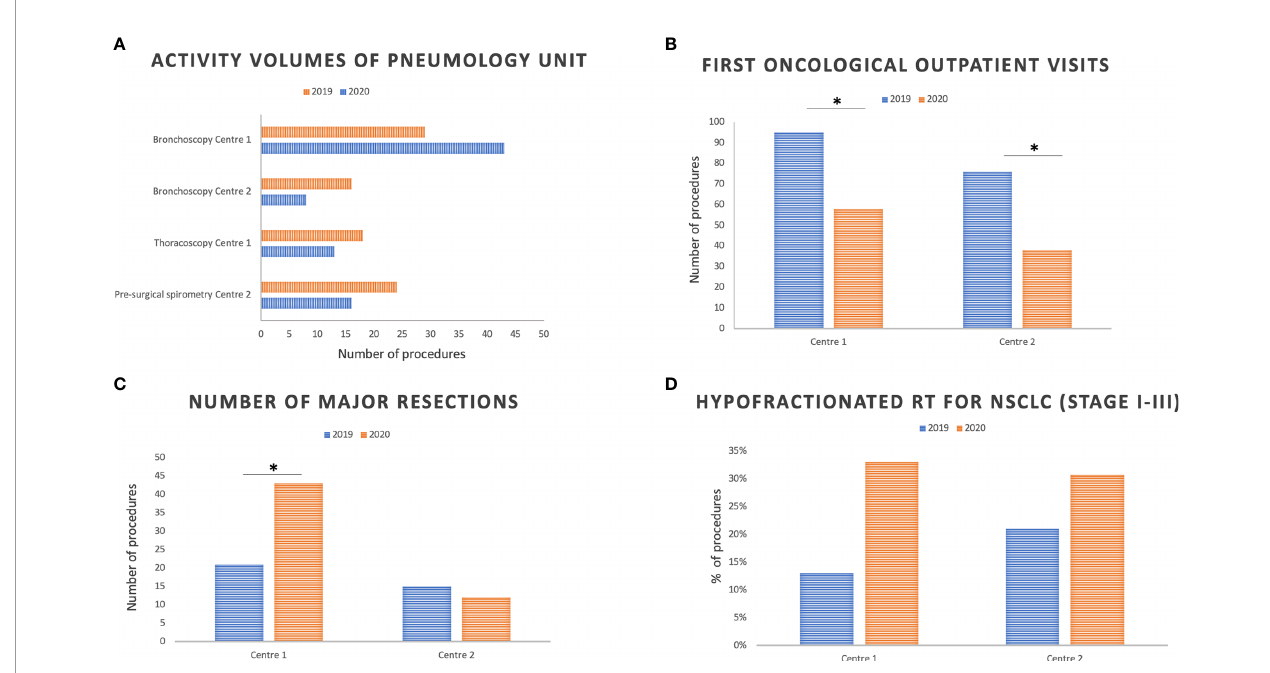
FIGURE 2 | Pneumology (A) , medical oncology (B) , thoracic surgery (C) , and radiation oncology (D) activity volumes at the two Centers in March and April 2019 compared with March and April 2020. RT, radiotherapy. *Indicates statistically signi fi cant differences between 2019 and 2020; p signi fi cance level: